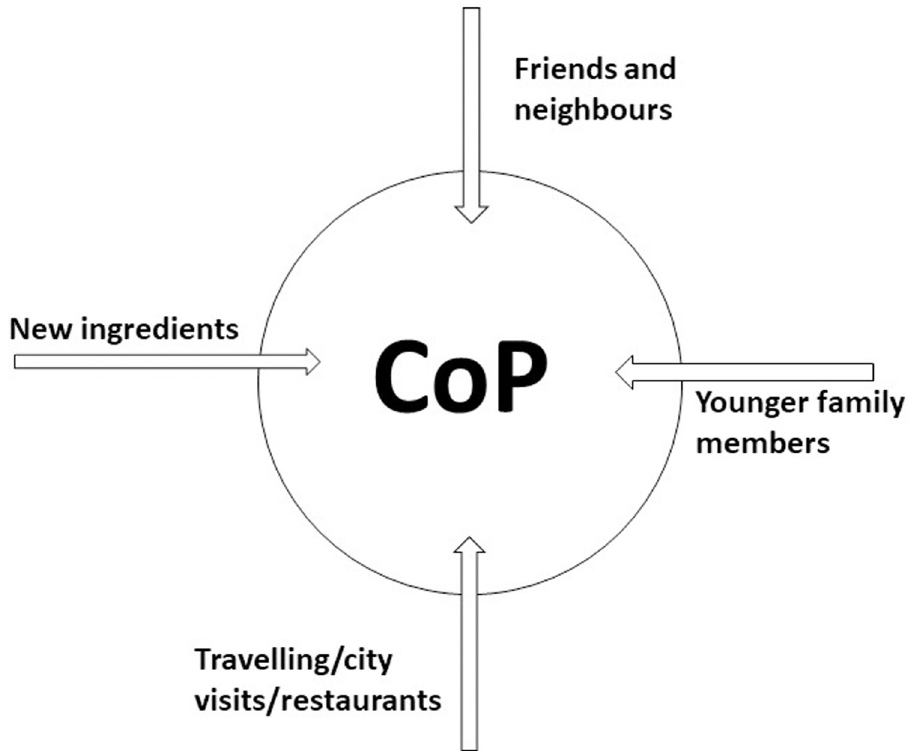
Fig 4. The influx of new practices in an existing Community of Practice